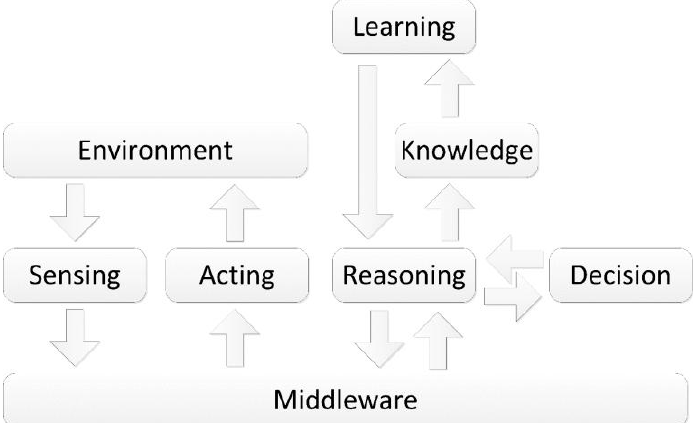
Figure 3. Information cycle and decision process of the AAL concept, resourcing to